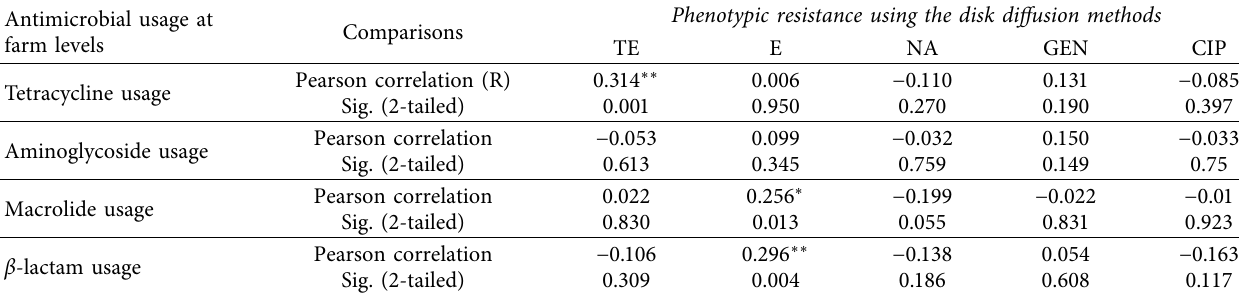
Table 4: Pearson correlation between antibiotic use at farm level and occurrence of resistance. Antimicrobial usage at farm